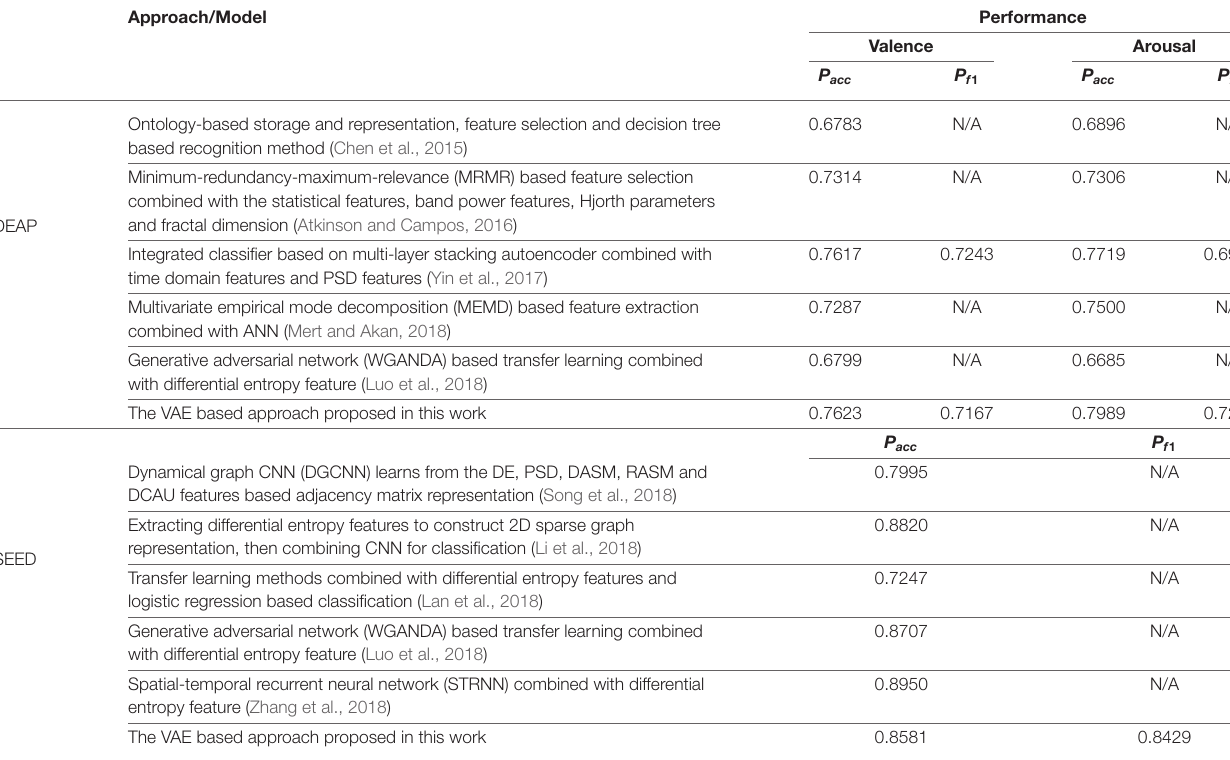
TABLE 6 | List of related works in recent years and the corresponding performance obtained.